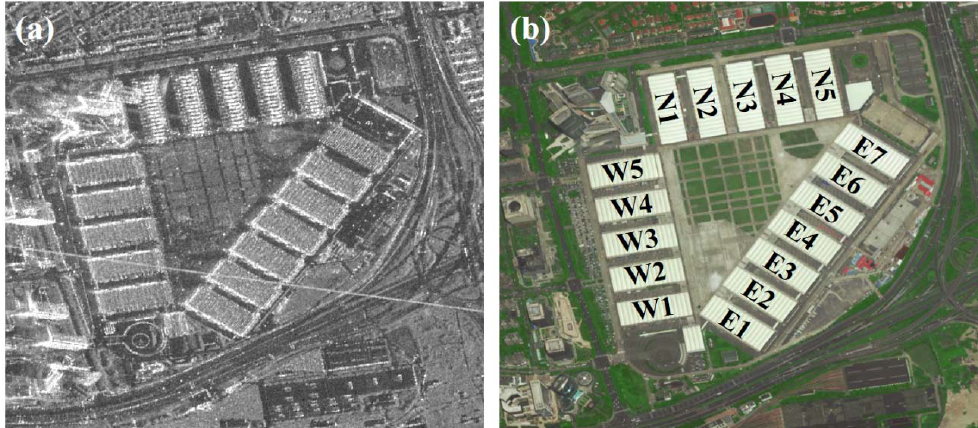
Figure 8. The ( a ) amplitude and ( b ) Google-Earth optical image of the Shanghai New International Expo Center (SNIEC).